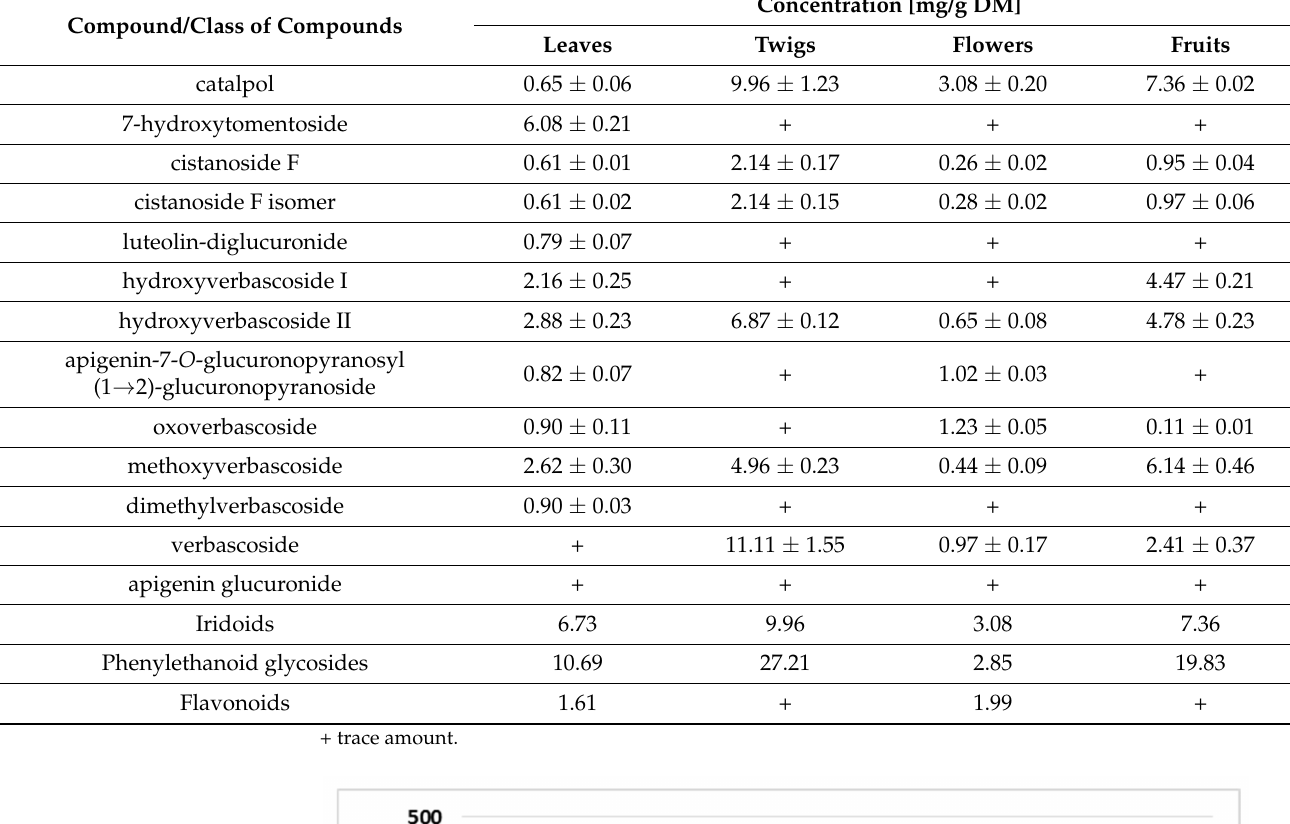
Table 2. Concentration of compounds and class of compounds in leaves, twigs, flowers and fruits of Paulownia Clon in Vitro.